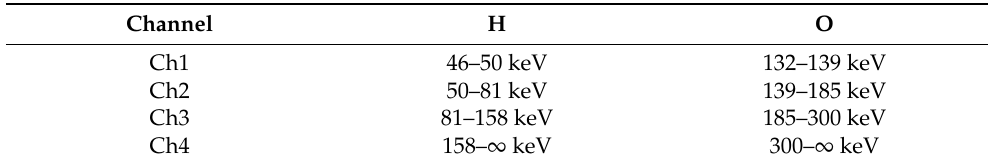
Table 1. Energy channels of NUADU.